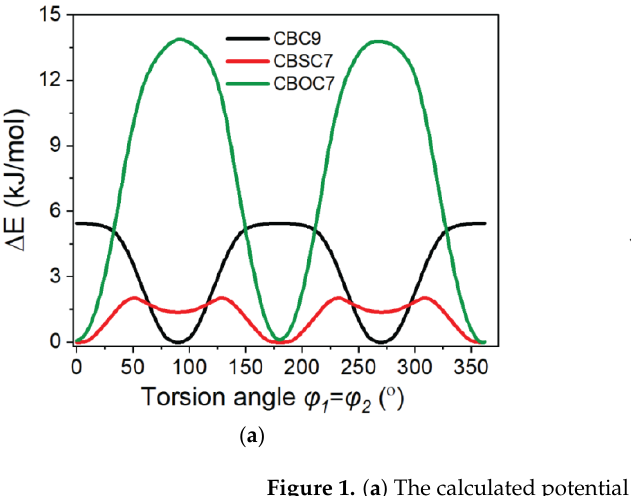
Figure 2. Probable conformers of the studied dimers. U — upright, F — flat (planar), M — mixed. The bend of a molecule is necessary for the formation of the twist-bend phase. The largest opening angle (144°) was obtained for the CBOC7OCB molecule. This caused its shape to be closer to a calamitic molecule than to a bent (banana) molecule, which means